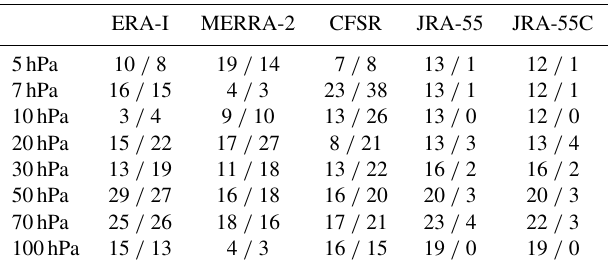
Table 3. Differences in the mean variances over 1981–2010 be- tween the ML and SL results, relative to the ML results (%), for the (left) Kelvin wave temperature and (right) MRG wave meridional